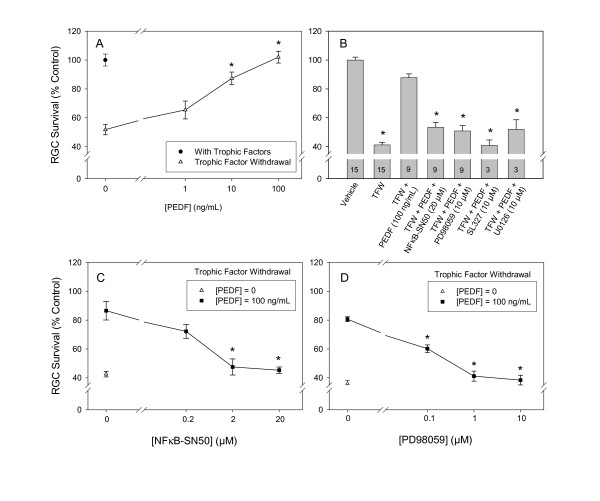
Protective effect of PEDF against trophic factor withdrawal-induced RGC toxicity. (A) Cells were treated with the indicated concentrations of PEDF in the presence or absence of trophic factors (n = 6). (B) Effects of various compounds on the PEDF protection against trophic factor withdrawal-induced cytotoxicity. Numbers on the bars represent sample sizes. TFW = trophic factor withdrawal. (C and D) Concentration-dependent reversal of the PEDF protection by NFκB inhibitor NFκB-SN50 and ERK1/2 inhibitor PD98059, respectively. Three trophic factors, bFGF, BDNF, and CNTF were removed from the culture medium in the trophic factor withdrawal group. * represents P < 0.05 vs. the respective control group by One-way ANOVA then Dunnett's test.